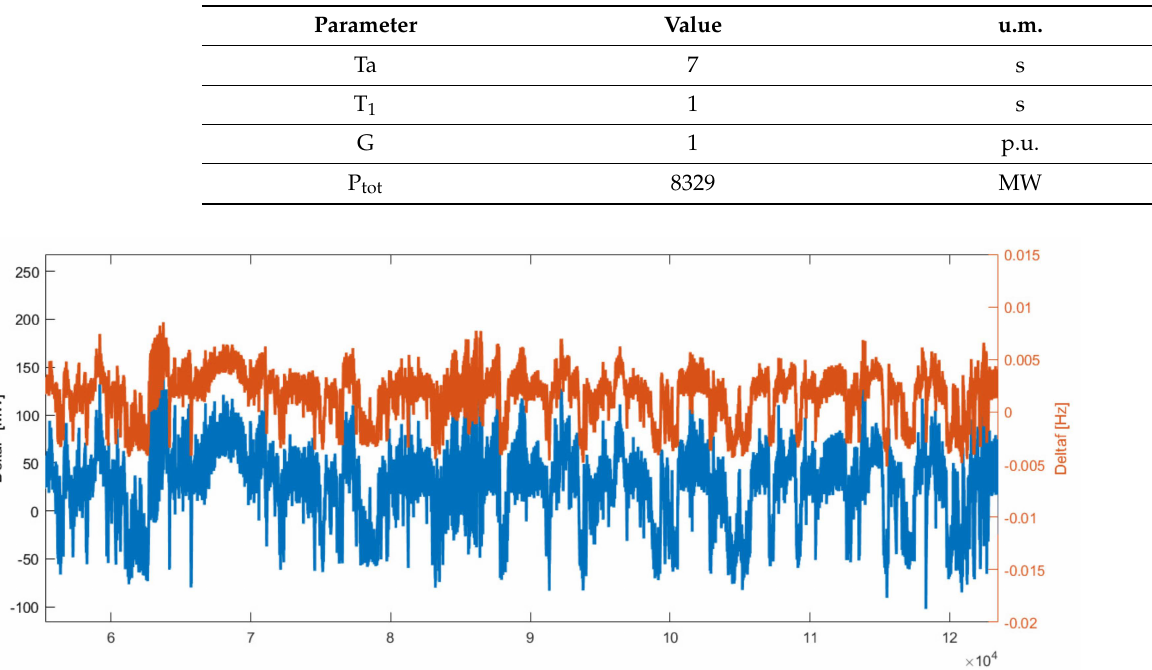
Figure 20. Delta P vs. Delta